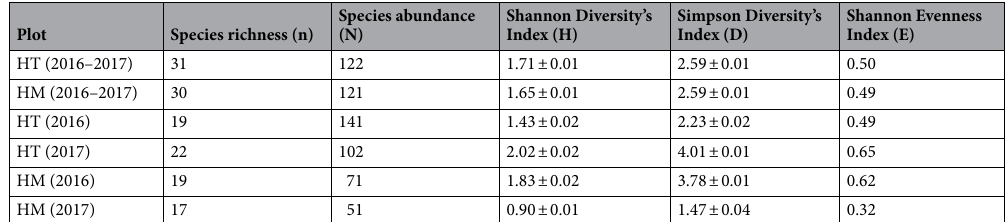
Table 1. Mean species richness and species abundance in the Heterogeneous (HT) and homogeneous (HM) hillslopes in 2016 and 2017 years.